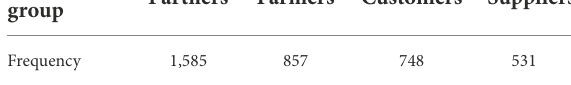
TABLE 5 Frequency of the nomination of each stakeholder